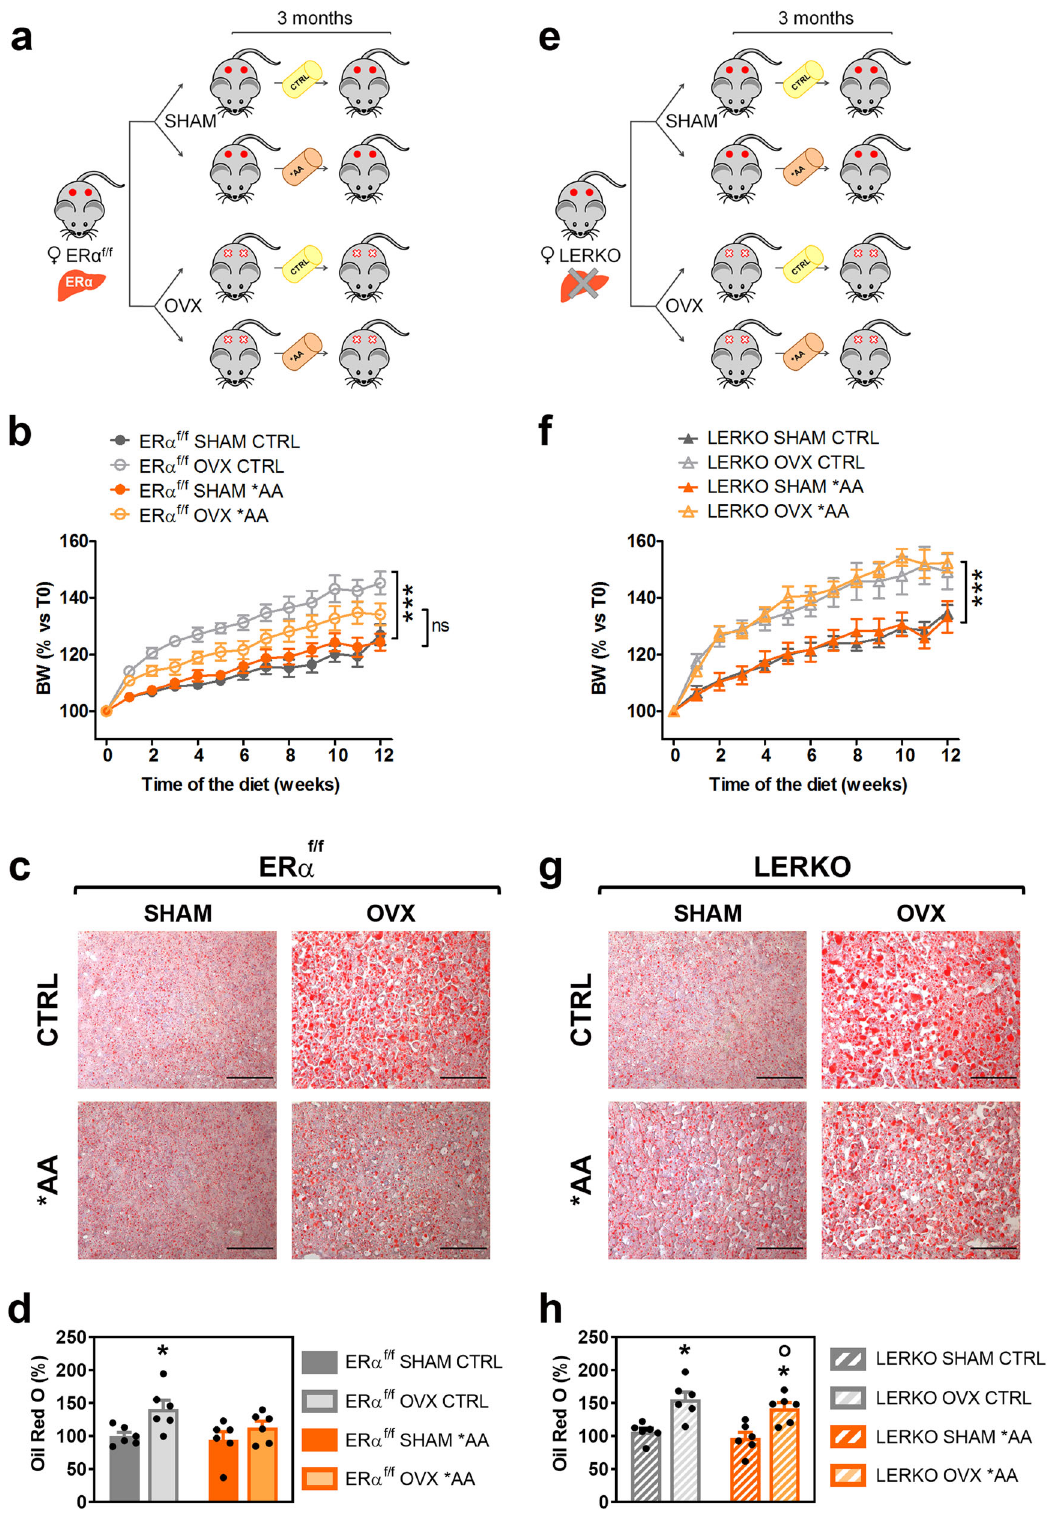
(Supplementary Fig. 8d). Differently from ER α f/f , the effect of the * AA diet in LERKO did not include genes relevant for increased mitochondrial respiration and for augmented transcription but appeared to be circumscribed to DNA repair (Fig. 4h) and regulation of extracellular structural proteins (Fig. 4i). The analysis of the identity of the DEGs revealed that in the LERKO fed with the * AA diet the pathways regulated were compatible